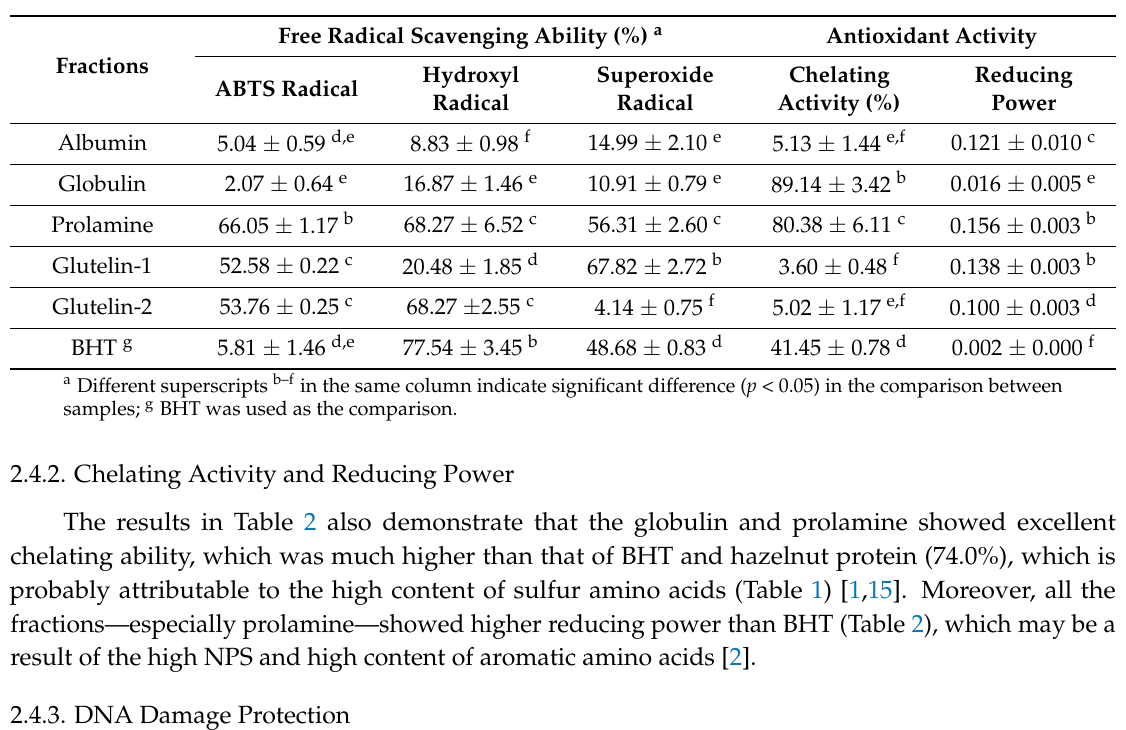
Table 2. Radical scavenging ability and antioxidant activity of coconut cake protein fraction at concentration of 100 µ g · mL − 1